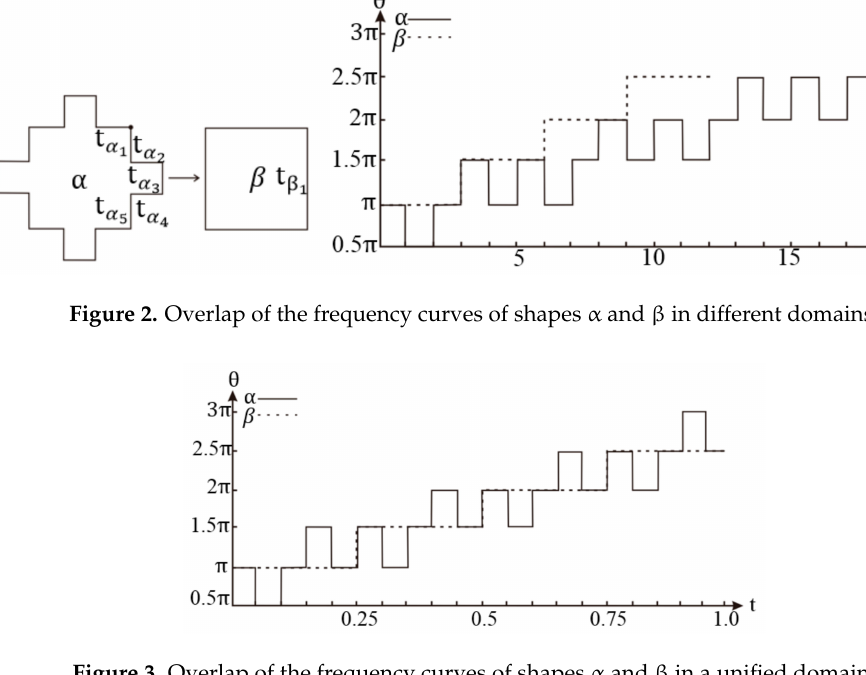
Figure 3. Overlap of the frequency curves of shapes α and β in a unified